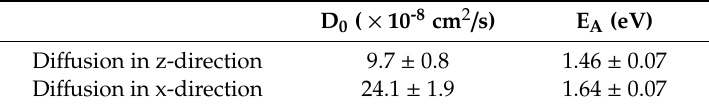
Figure 5. Arrhenius plot of the diffusion coefficients of Yb in LiNbO 3 for diffusion parallel to the x- and z-axis. The fitted lines correspond to Equation (7). Table 2. Di ff usion constants and activation energies for Yb di ff usion in LiNbO 3 . Table 2. Diffusion constants and activation energies for Yb diffusion in LiNbO 3 .